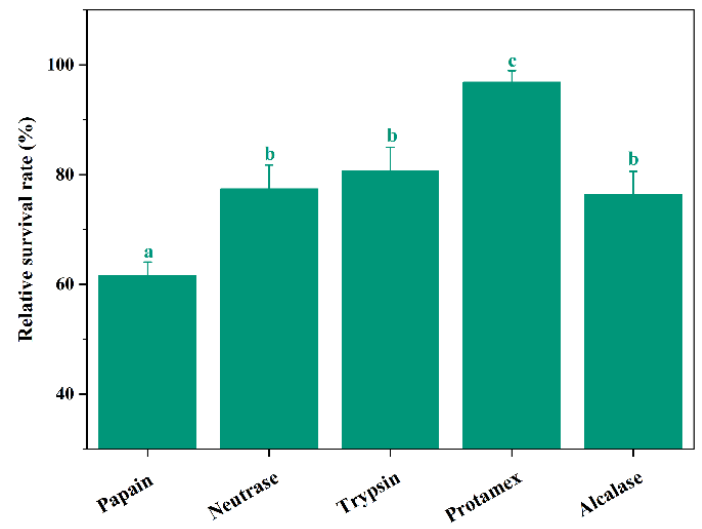
Figure 1. Cryoprotective activities of enzymatic hydrolysates from defatted Antarctic krill at a 1.0 mg/mL concentration treated with different proteases. Bars with different lowercase letters (a, b, and c) indicate significant differences ( p < 0.05).